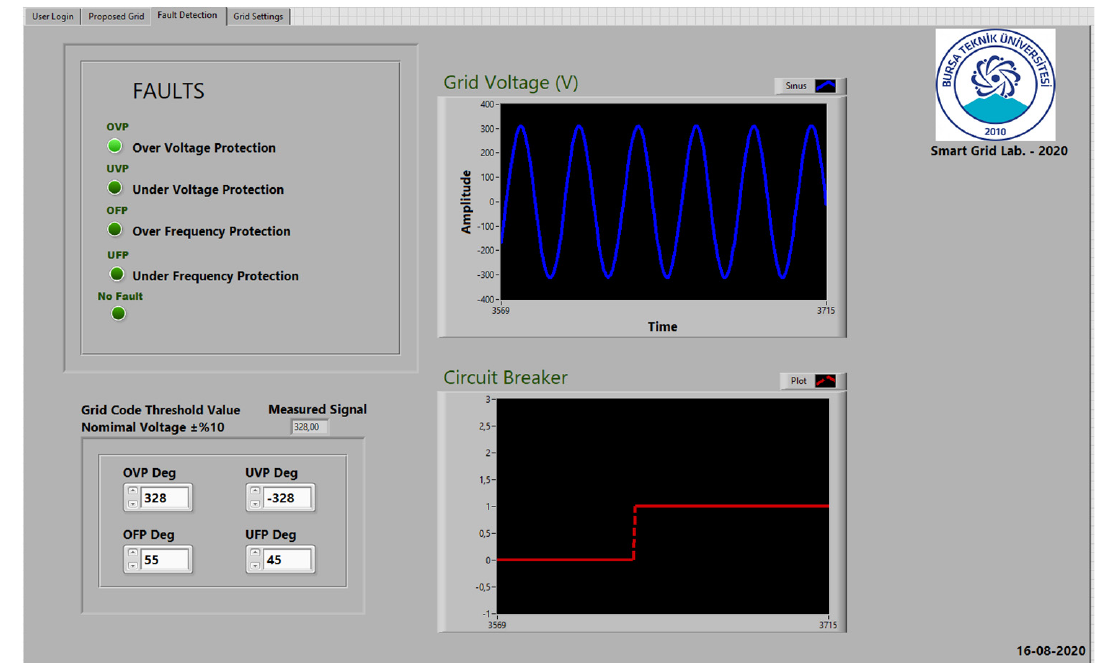
Figure 5. OVP condition DGPS.